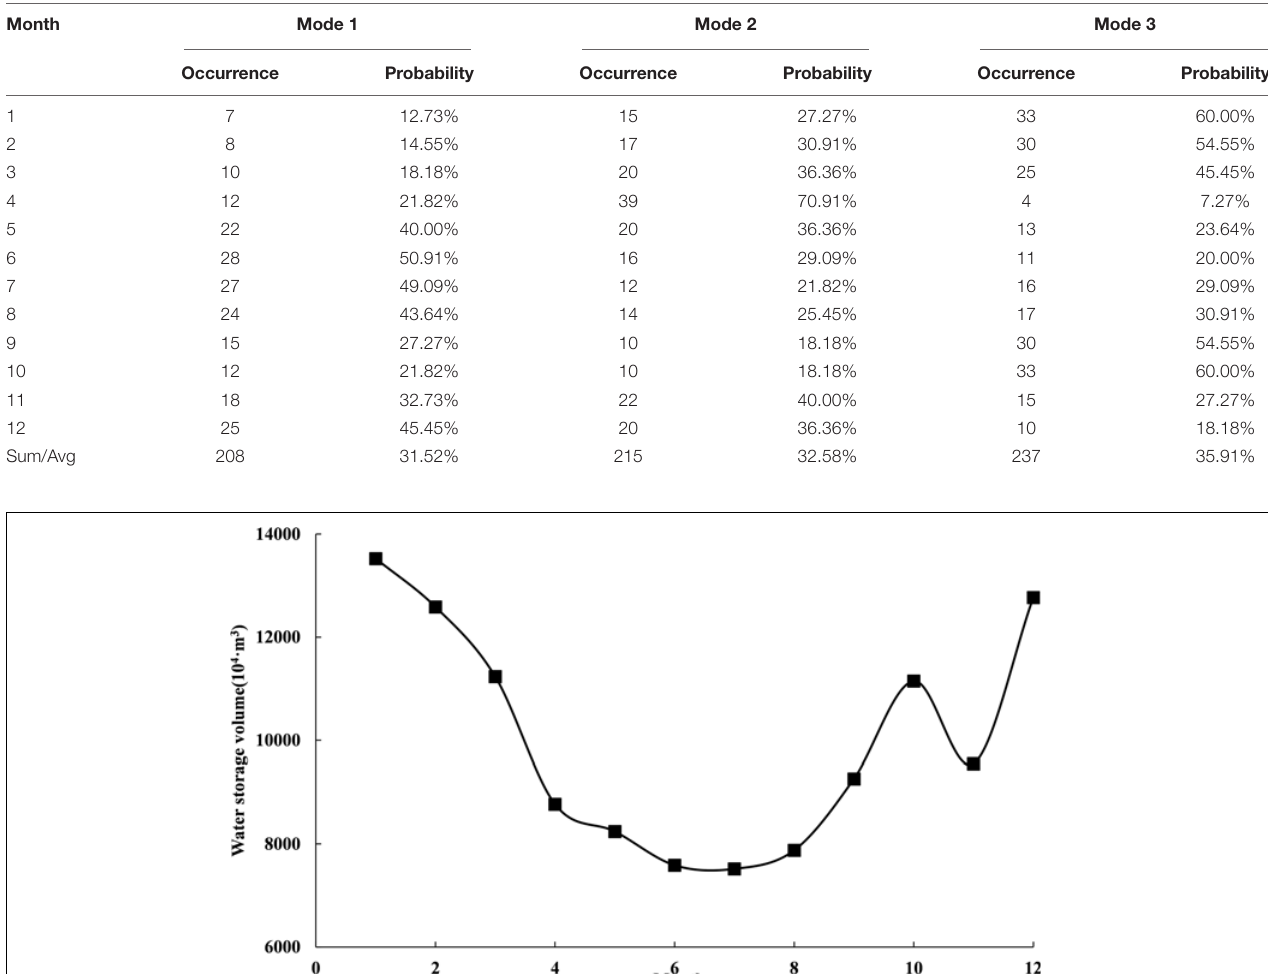
FIGURE 13 | Monthly average storage volume of HQ Reservoir.